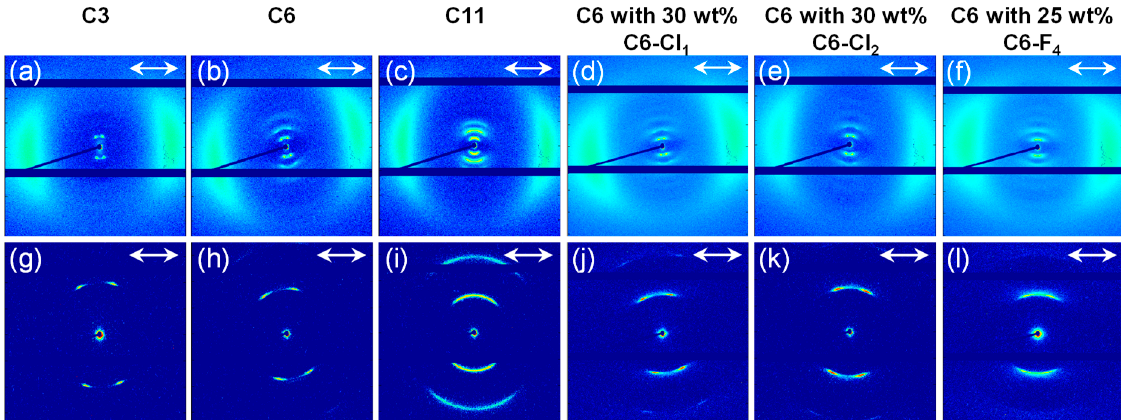
Figure 2. WAXS (top row) and MAXS (bottom row) spectra of LC membranes consisting of LCs with various alkyl spacer lengths and various halogenated LCs. ( a , g ) C3 , ( b , h ) C6 , ( c , i ) C11 , ( d , j ) C6 with 30 wt% C6-Cl 1 , ( e , k ) C6 with 30 wt% C6-Cl 2 , ( f , l ) C6 with 25 wt% C6-F 4 . The single arrow shows the alignment direction.